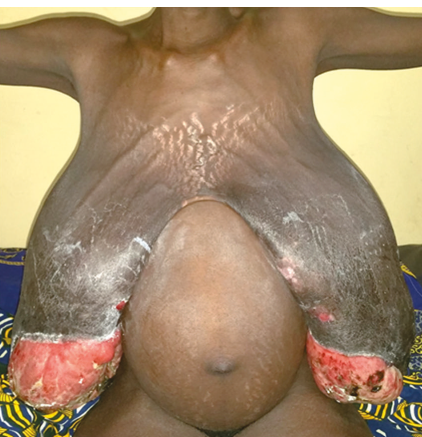
Figure 1: Bilateral giant breasts at 32-week gestation, with collateral venous circulation and trophic changes marked by the necrosis of the distal third of the mammary skin involving the nipple- areolar